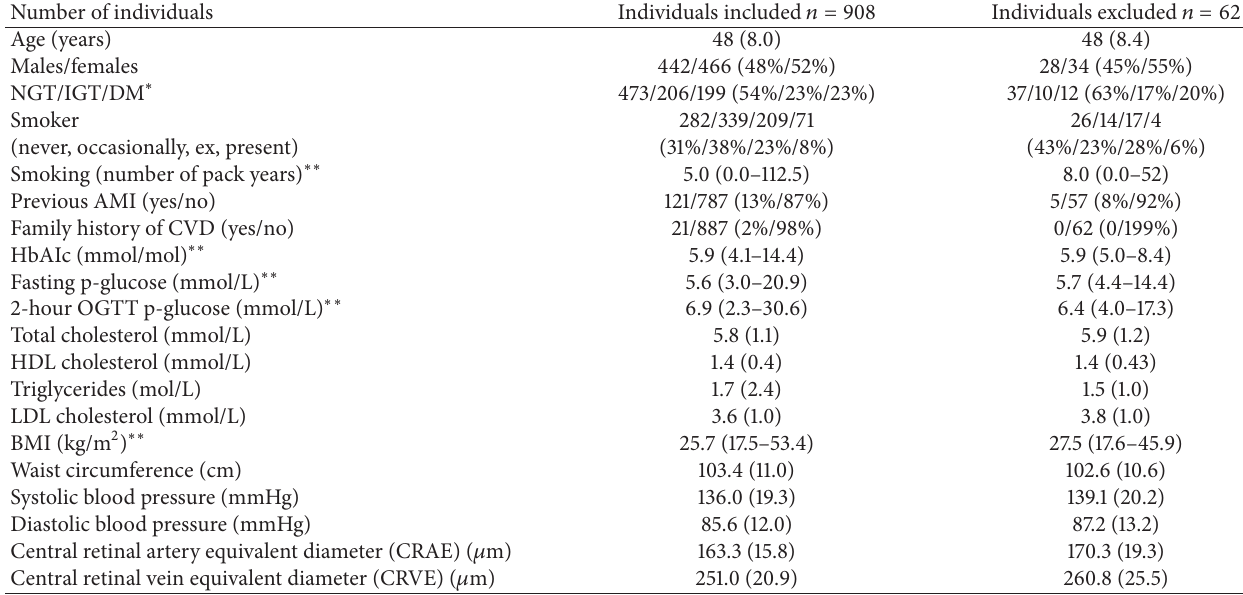
Table 1: Clinical characteristics of the study